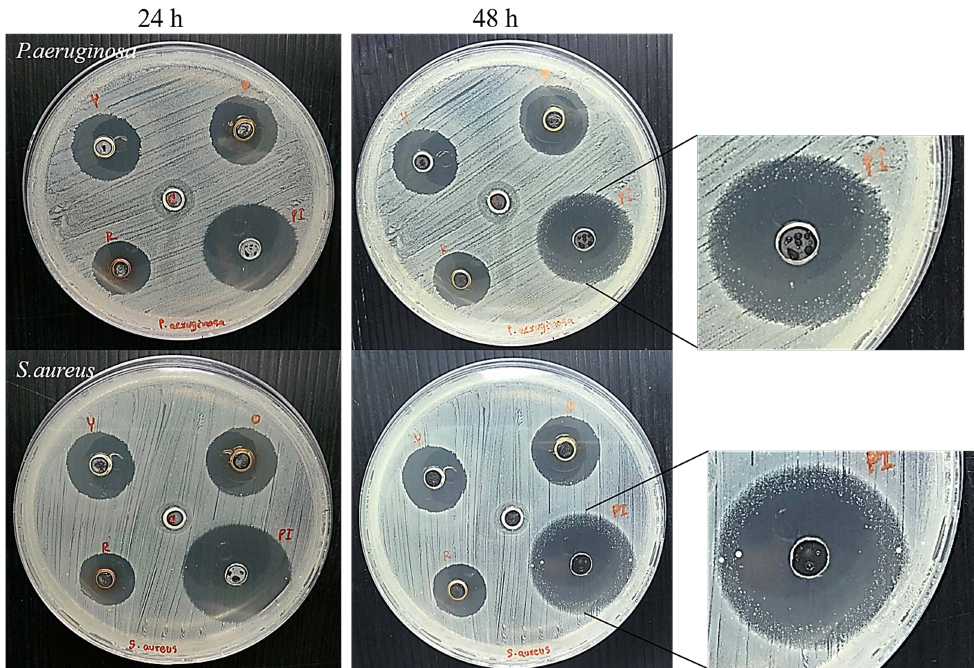
Figure 6. Antimicrobial activity of the AgNPs gel determined by the well diffusion method. The AgNP gels (S1 [yellow], S2 [orange], S3 [red]), povidone iodine and control gel were dropped into wells and incubated with pathogens for 48 h at 37 ◦ C. The inhibition zones were measured in mm in diameter at 24 h and 48